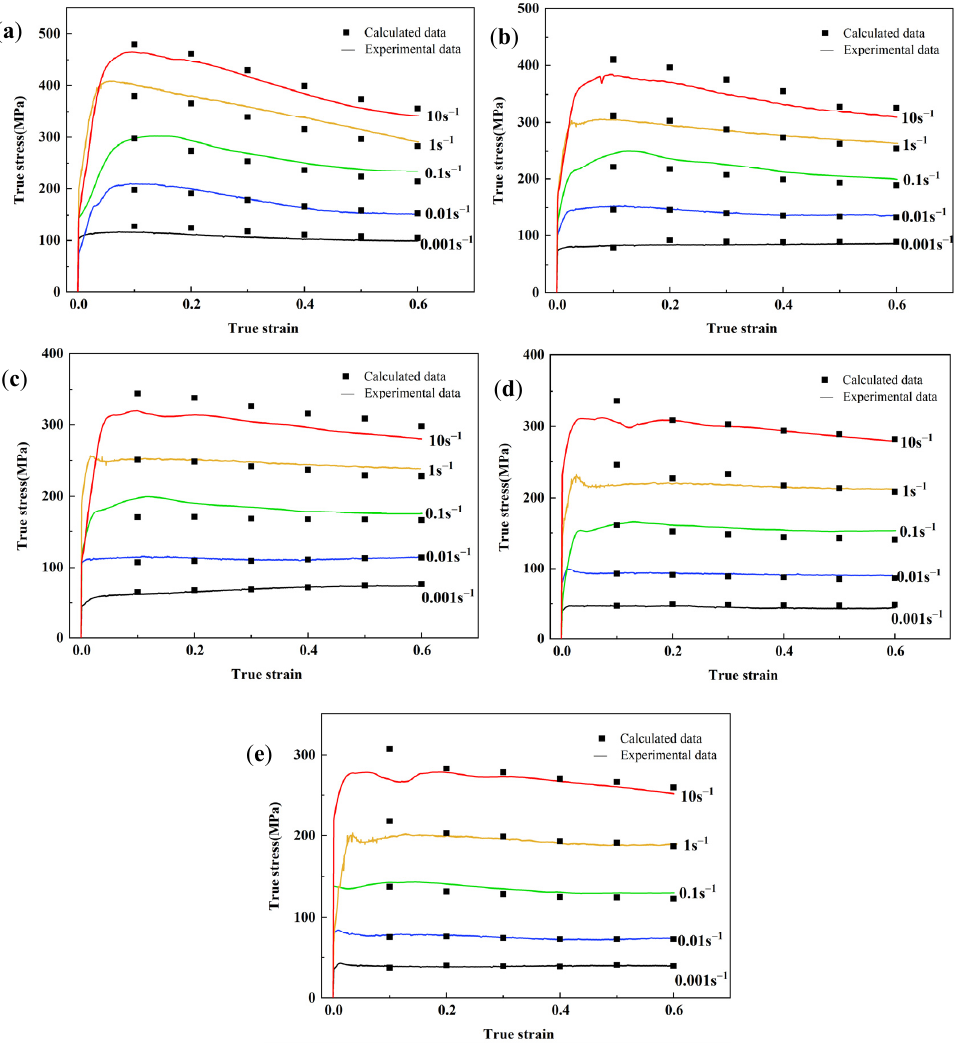
Figure 9. Predicted stress values and experimental stress values: ( a ) α + β phase field, 700 ◦ C; ( b ) α + β phase field, 730 ◦ C; ( c ) α + β phase field, 760 ◦ C; ( d ) β phase field, 790 ◦ C; and ( e ) β phase field, 820 ◦